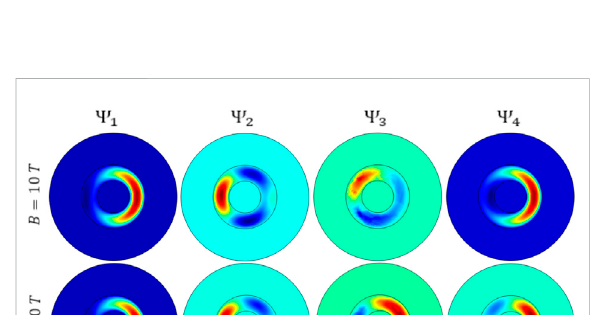
FIGURE 4 Lowest four wave functions for CCSDQ with R c = 1 a *, R s = 2 a *, H = 10 a *, for different values of α R , for B = 20 T .